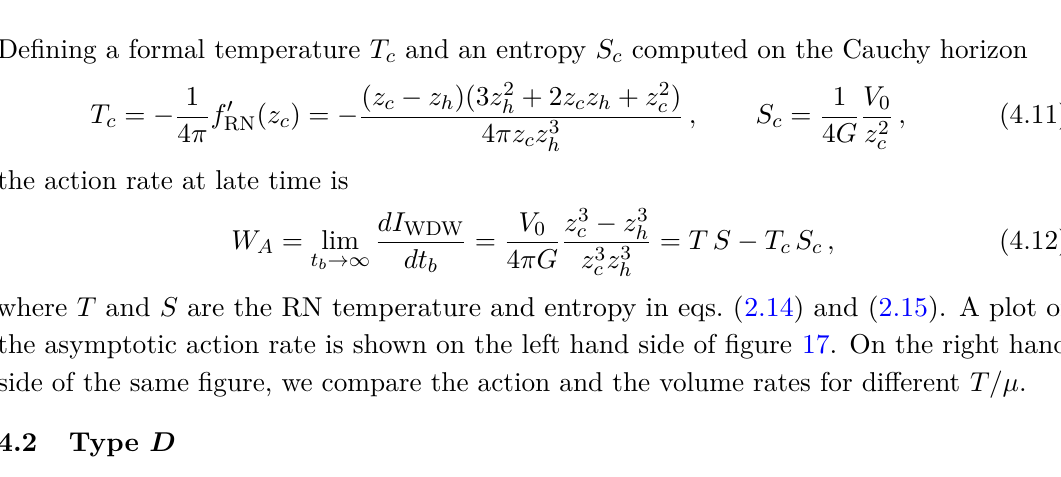
Figure 16 . Action complexity rate as a function of time for some examples of RN case, with V 0 / (16 πG ) = 1 . Top: almost extremal case with T/µ = 1 . 4 · 10 − 3 , ρ = 3 . 43 and z h = 1 . The approximate analytical expression in eq. (4.8) in red is compared with numerical one, in black. In the scale of the plot, the curves with L 2 ct = 0 . 1 , 1 , 10 all coincide with the black curve. Bottom: case with T/µ = 0 . 28 , ρ = 0 . 8 and z h = 1 (for various L 2 ct